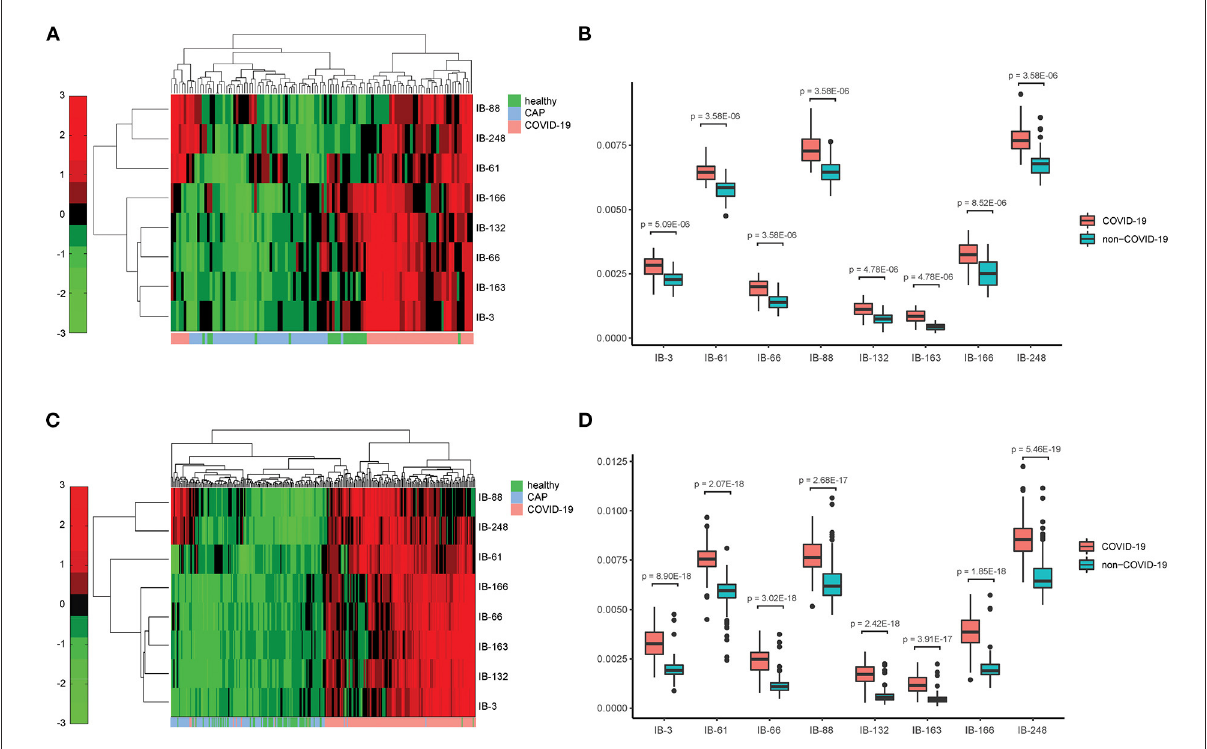
FIGURE5 Chest CT-based imaging biomarkers provide consistent and significant distinction between COVID-19 patients and others across hospitals. (A) Heatmap of the relative abundance of imaging biomarkers shows distinct clusters with respect to COVID-19 and non-COVID-19 groups in training cohort; (B) Individual imaging biomarker shows significantly higher relative abundance in COVID-19 patients in training cohort; (C) . Heatmap of the relative abundance of imaging biomarkers shows distinct clusters with respect to COVID-19 and non-COVID-19 groups in validation cohort; (D) Individual imaging biomarker shows significantly higher relative abundance in COVID-19 patients in validation cohort.